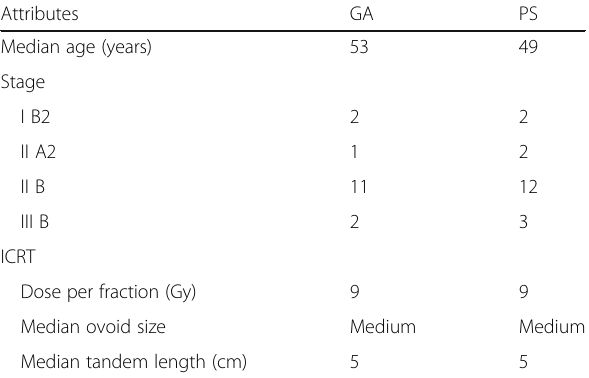
Comparison of EQD2 doses received by 0.1 cc of OARs